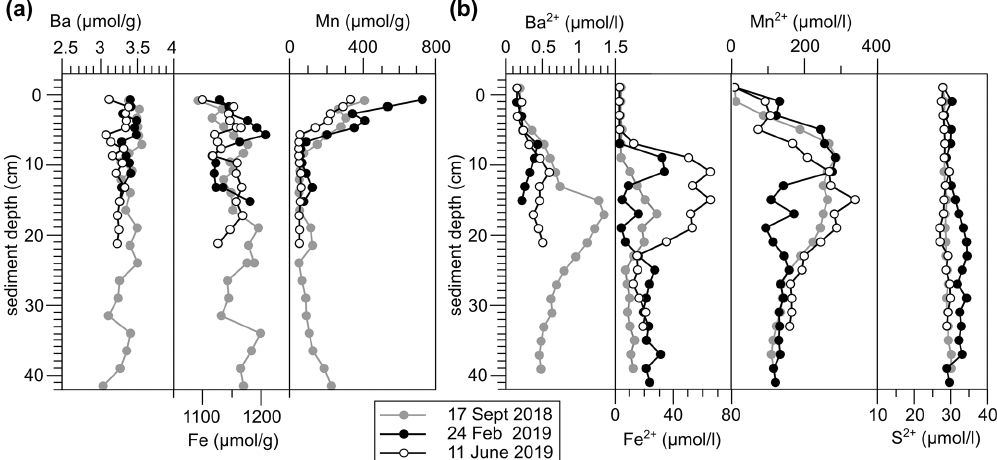
Figure 4. (a) Solid phase and (b) dissolved trace element profiles of site GF 117 at each sampling occasion.